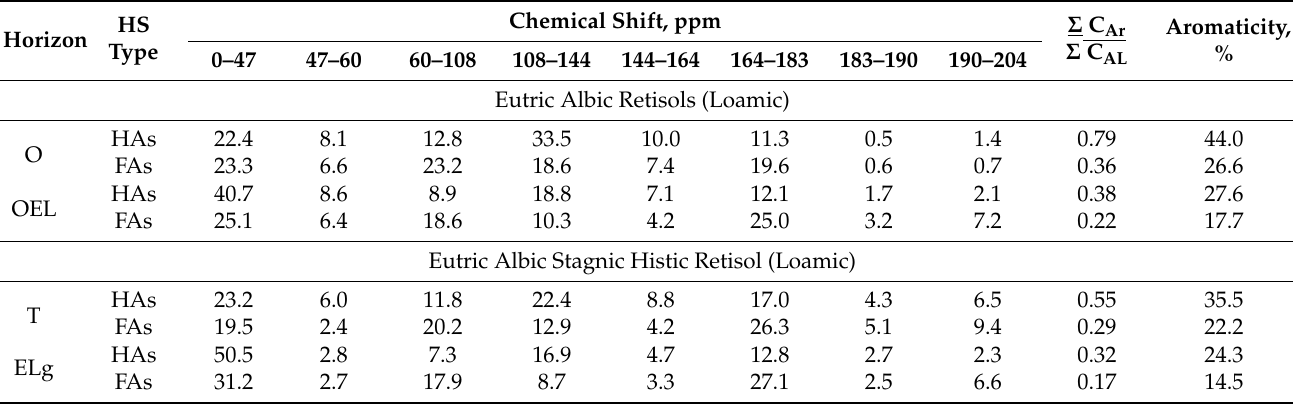
Table 2. Percentage of carbon in the main structural fragments of humic substances (according to 13 C NMR